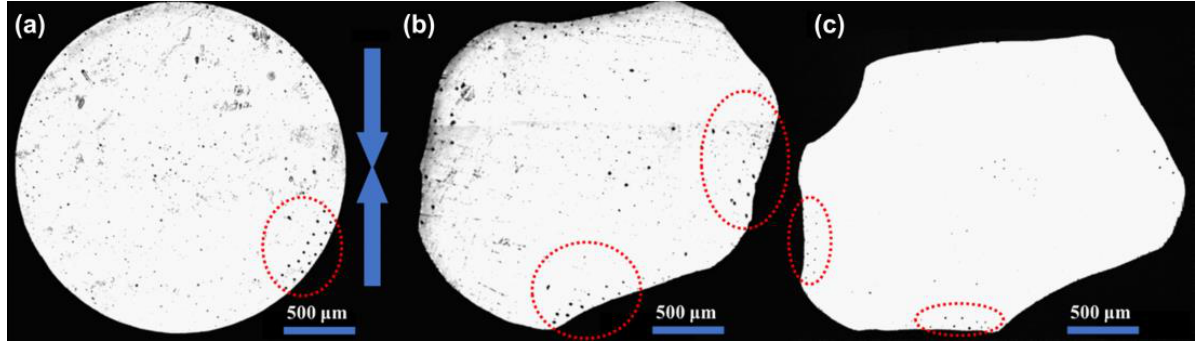
Figure 2. Barycentric section of ( a ) sphere before the cold-compaction. ( b ) deformed sphere at 196 MPa and ( c ) at 500 MPa; the arrows indicate the direction of the compaction. In the red dotted circles, the micro-indentation imprints are